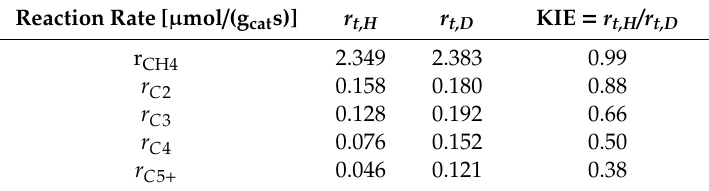
Table 5. Kinetic isotope effects (KIE) for the product formation (483 K, 1.85 bar, H 2 /CO = D 2 /CO = 10).